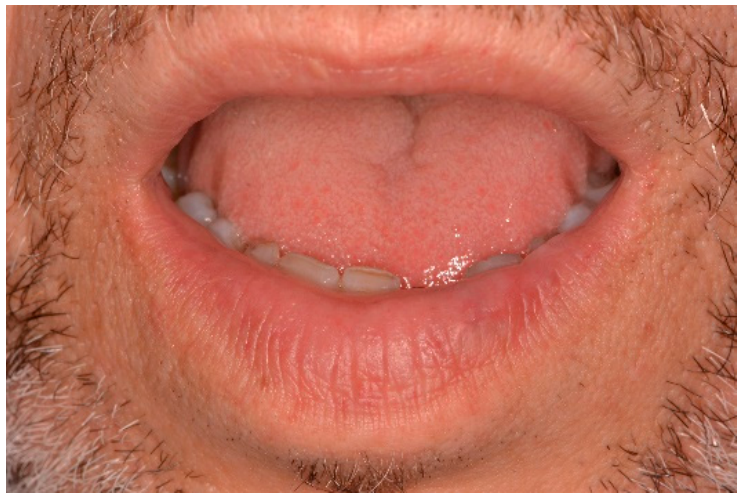
Figure 15. Clinical aspect of healing at 2 weeks post operation. Transmucosal photo-thermo-coagulation was performed using an Nd:>YAG laser.